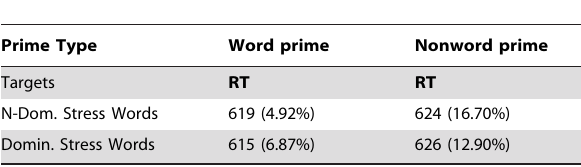
Table 6. Mean response latencies (RT) as a function of prime type and target type and percentages of stress errors (in parentheses) in Experiment